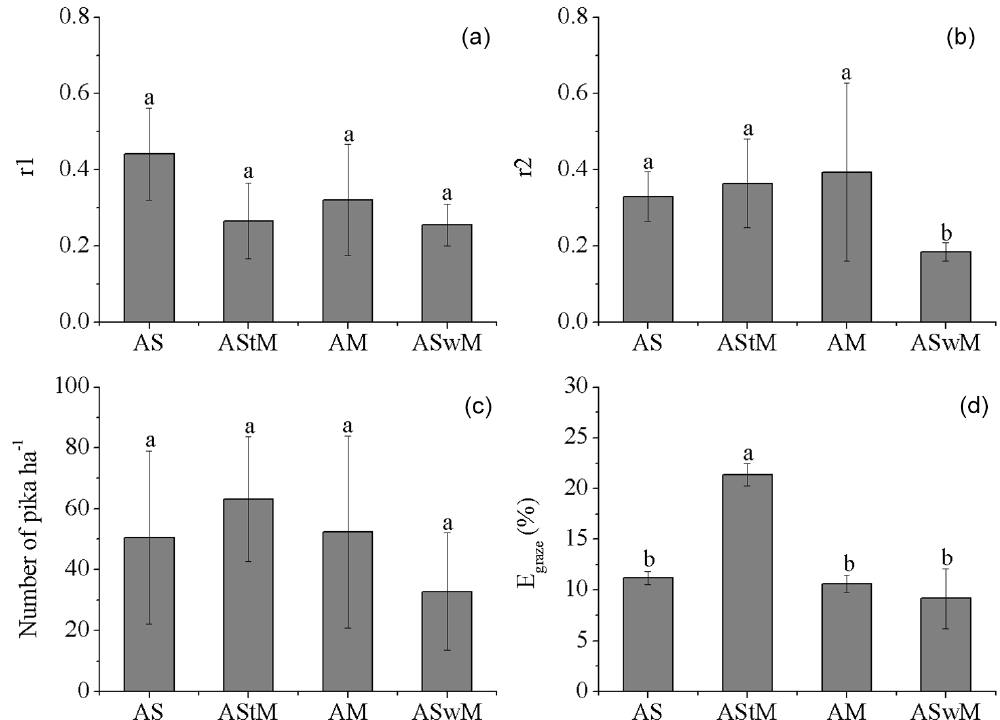
Figure 9. (a) Ratio between in-use burrow exits and total burrow exits (r1); (b) ratio between number of pika and in-use burrow exits (r2), (c) number of pikas (ha − 1 ) , and (d) effects of pika grazing on above-ground biomass (%) in four types of alpine grasslands (see Fig. 1). Error bar indicates ± standard deviation and different letters above the error bar indicate significant differences among different grassland types ( p